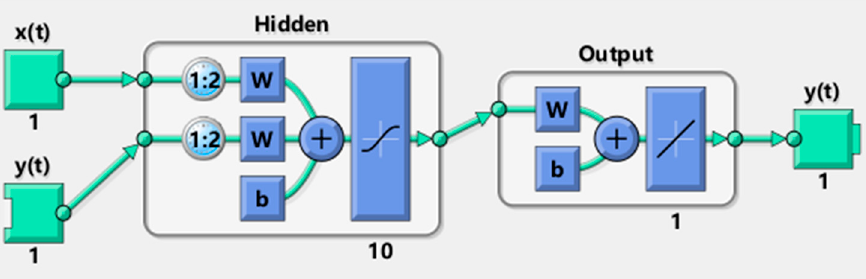
Figure 16. NARX Neural Network for single dataset training and 10 hidden layer nodes.